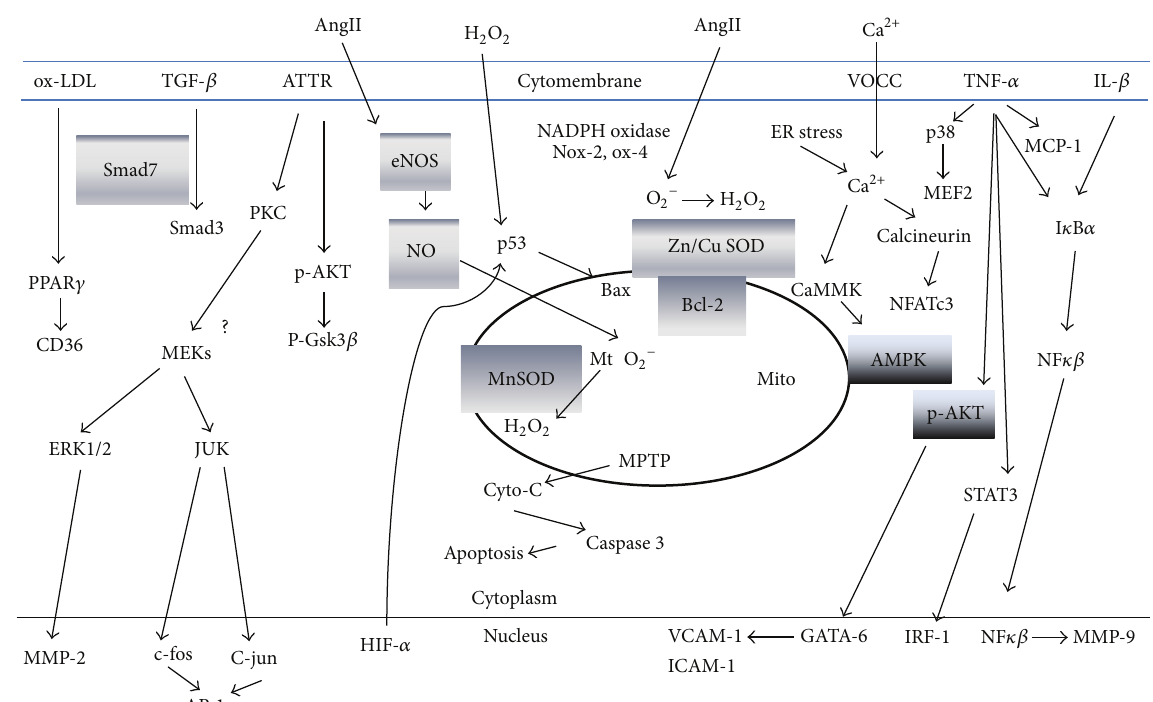
Figure 2: Molecular targets in cardioprotective actions of tanshinones. This schematic illustration summarizes the mechanisms involved in cardioprotective actions of tanshinones based on studies on TIIA and CT. The targets with amelioration by tanshinones are indicated with the shaded text box. The targets with attenuation by tanshinones are indicated without shaded text box. Main cardioprotective actions of tanshinones were characterized via anti-inflammatory, antioxidant, antiapoptosis, antiproliferation/fibrosis, and vasodilator actions. The anti-inflammatory actions of tanshinones are via inhibition of TNF- 𝛼 and IL- 𝛽 and their downstream signaling pathways including IkB 𝛼 /NF- 𝜅 B, MCP-1, STAT3, and Akt, resulting in reduced IRF-1 and GATA-6 proteins expression which in turn decreases VCAM-1. ERK1/2, p38, and JNK are also inhibited. By suppressing ERK1/2 and JNK phosphorylation, CT reduces AP-1 activation. However, it is undetermined whether CT inactivates AP-1 via reduction of c-fos and c-jun. The inhibition of NF- 𝜅 B’s translocation to nucleus results in decreased MMP-9 expression. Furthermore, TIIA decreases PPAR 𝛾 expression and CD36 which inhibits cell formation and subsequently inflammation. TIIA exerts antioxidant effects by enhancing antioxidant enzymes (Cu/Zn SOD, Mn-SOD, and GSH) and decreasing intracellular H 2 O 2 /O 2− , mitochondrial O 2− levels, and Nox 2 and Nox 4. The antiapoptosis action of tanshinones is via balancing Bcl-2/Bax protein, reducing cytochrome C release, and inhibiting caspase 3 activation. Bax can be activated by p53 which can be activated by HIF-1 𝛼 . TIIA inhibits HIF-1 𝛼 translocation to nucleus which in turn could reduce p53-induced Bax activation and ultimately apoptosis. Tanshinones inhibit the apoptosis by reducing mitochondrial superoxide level and enhancing Mn-SOD, increasing NO level, and decreasing intracellular calcium level. Antiproliferation/fibrosis actions of TIIA involve calcineurin-NFAT pathway, TGF- 𝛽 /Smad pathway, PKC (ERK1/2 and JNK)